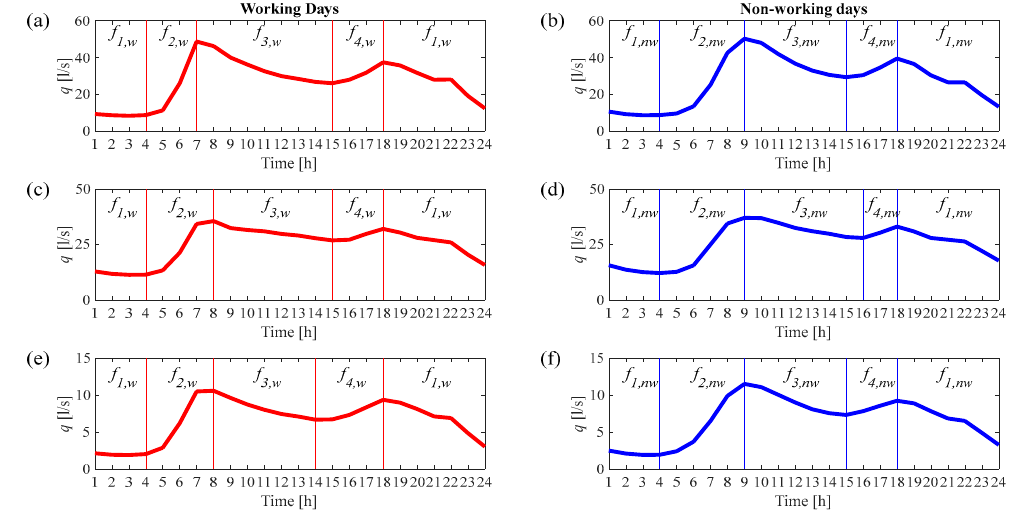
Figure 3. Average daily pattern of hourly demands during working (left-hand column, ( a , c , e )) and non-working days (right-hand column, ( b , d , f )) and initial and final ends of the time phases f 1 , f 2 , f 3 , and f 4 relating to DMA1 (row 1), DMA2 (row 2) and DMA3 (row 3).